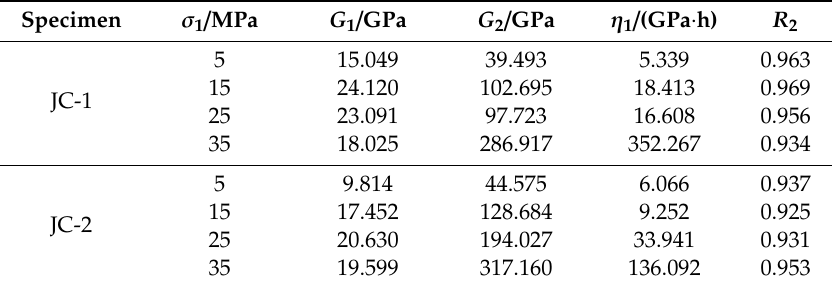
Table 2. Parameter values of classical Nishihara model.